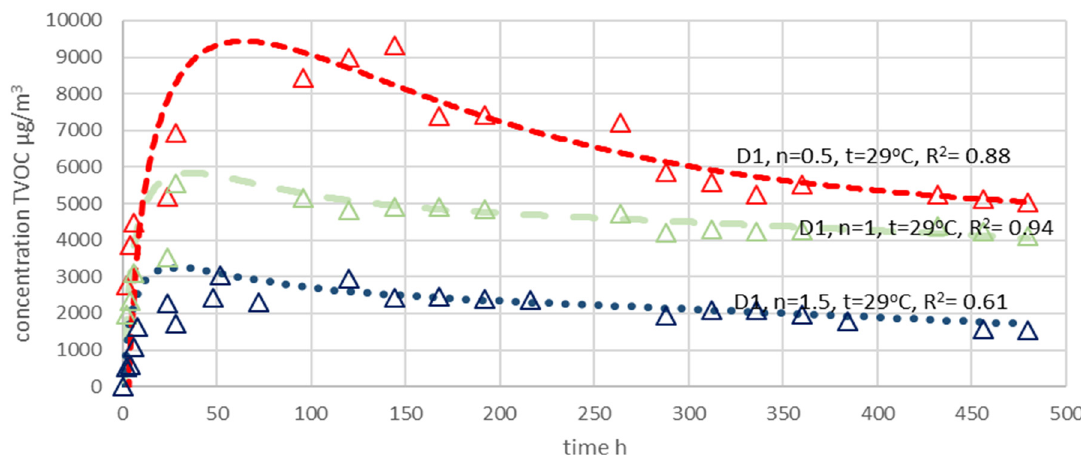
Figure 10. The TVOC emission profiles from D1 sandwich floor systems (testedfor 480 h) for three air changes rates ( n = 0.5 h − 1 , 1 h − 1 and 1.5 h − 1 ) at 29 °C and RH = 50% in the emission test chamber. (D1 sample is a floor system made of: polyurethane solvent primer and polyurethane adhesive (see Table 3); significant VOCs compounds for these products are provided in Table 1).